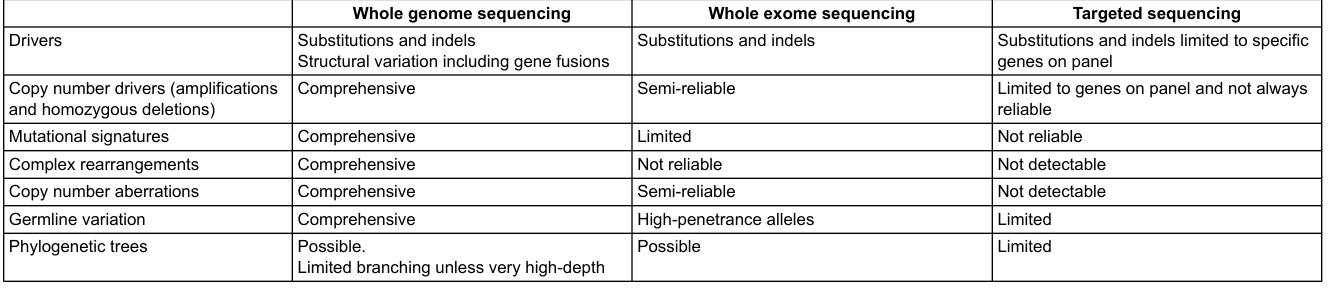
Table 1: Data obtainable from various sequencing experiments. Whole genome sequencing Whole exome